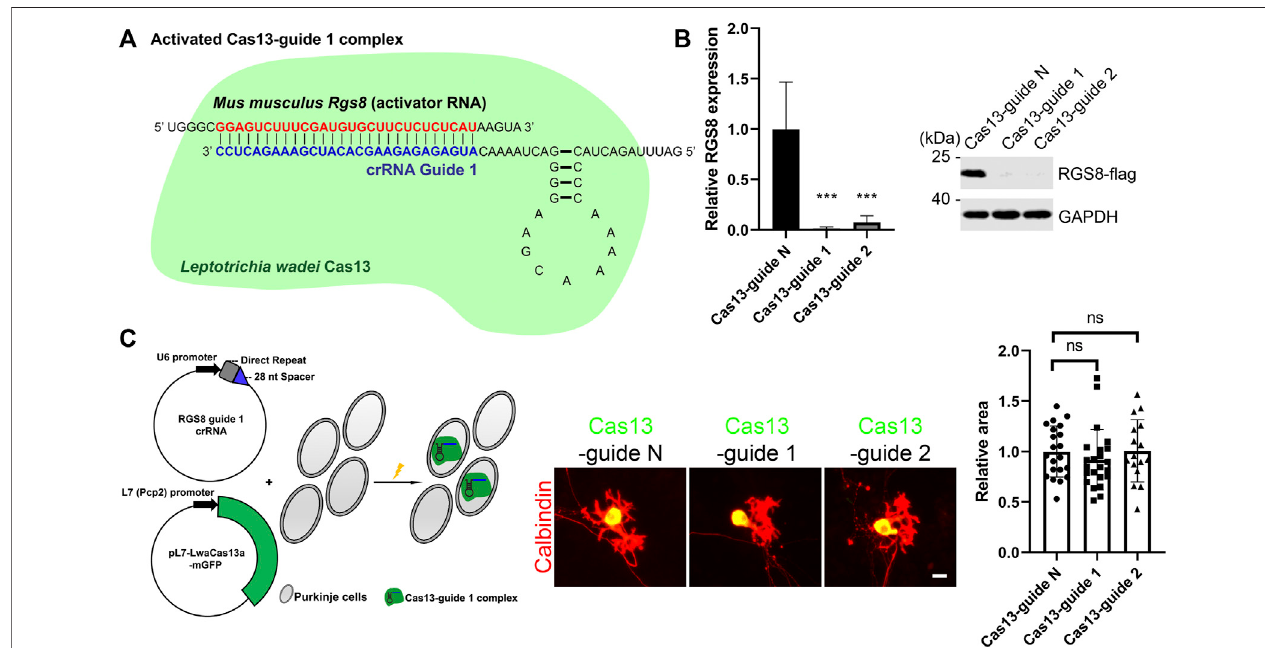
FIGURE 1 | CRISPR-Cas13-mediated RGS8 silencing in cerebellar Purkinje cells. (A) This is a schematic diagram of an example of an activated Cas13 – guide complex. The target RGS8 RNA acts as an activator RNA. Once the Cas13 – guide 1 complex binds to target RGS8 RNA, Cas13 – guide 1 complex will be activated and generate RNase activity to cleave the RGS8 transcripts. (B) HEK293T cells expressing RGS8-FLAG were transfected with indicated Cas13-guides or control. Western blotofHEK293TcellsofindicatedCas13-guidesandcontrolgroupstainedforanti-FLAG.Quanti fi cationofproteinlevelsfromWesternblots.Themeanvalueofthe controlgroupis1.00±0.465;themeanvalueoftheisCas13-guide1is0.01±0.013;themean valueoftheisCas13-guide2is0.07±0.066.n=4.*** p < 0.001inone- way ANOVA with multiple comparisons. (C) The schematic illustration on the left side of the panel shows that Purkinje cells were transfected Cas13 and crRNA at the setupoftheculture.ThetransfectedPurkinjecellswereidenti fi edbyGFPandCalbindinstainingindissociatedcultures.ThemeanvaluesofdendriticareaofthePurkinje cellsweremeasured fromthreeindependent experiments; controlswerethetransfected Cas13-guideN(nontargeting)cells.Control:1.00±0.252,n=21cells;Cas13- guide 1: 0.92 ± 0.298, n = 23 cells; Cas13-guide 2 transfection: 1.01 ± 0.309, n = 16 cells. Difference was not statistically signi fi cant in one-way ANOVA. Scale bar is 20 µm. Data are expressed as mean ±